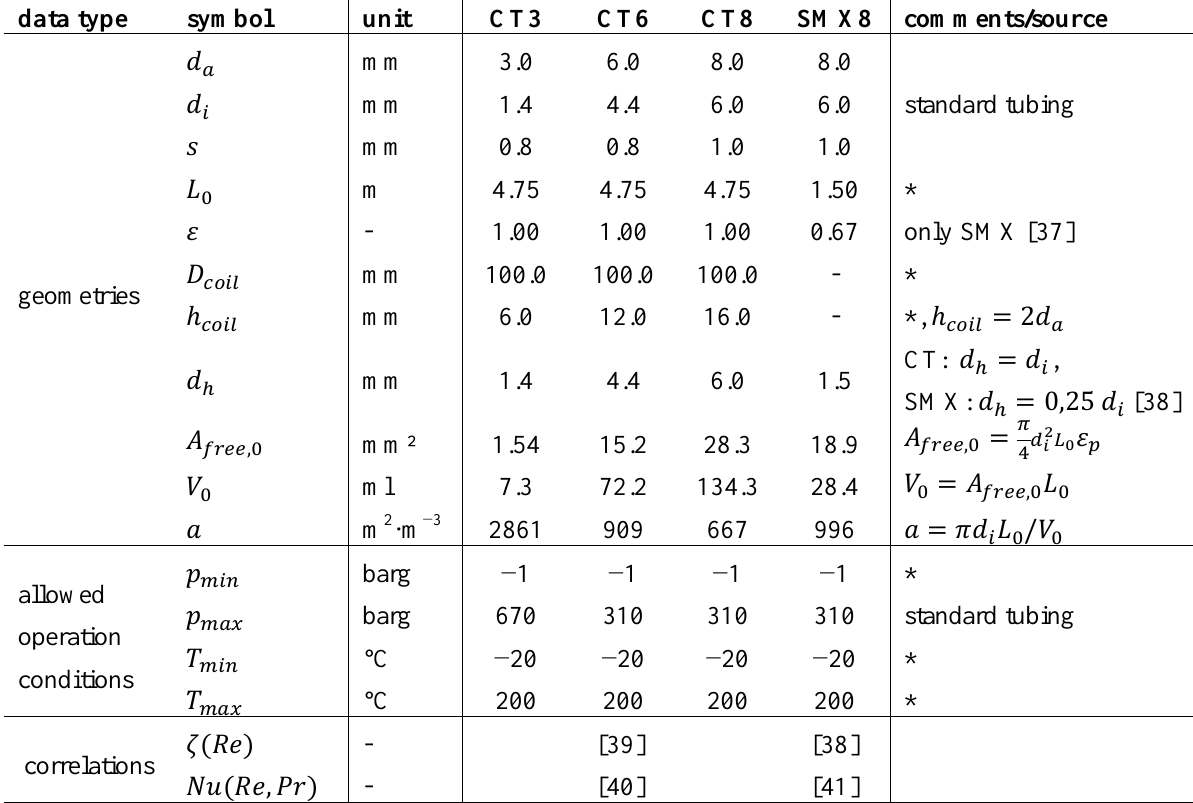
Table 2. Simplified reactor database for coiled tube (CT) and static mixer reactors (SMX) (* assumption for demonstration purpose).